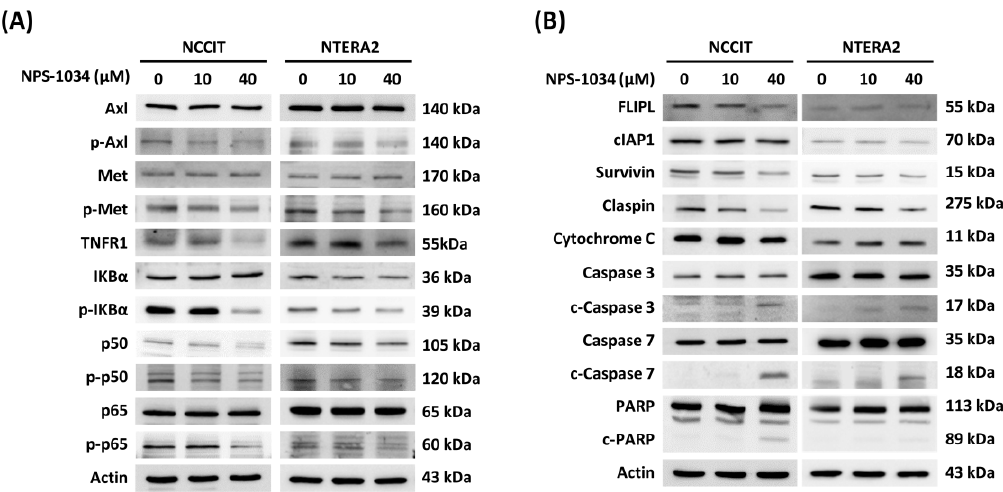
Figure 4. NPS-1034 potentially triggered an apoptotic pathway in TC cell lines via the TNFR1 pathway. ( A ) NPS-1034 inhibits the p-Axl, p-Met and downstream pathway NF- κ B of TNFR1, which might lead to certain gene expressions in both NCCIT and NTERA2 cell lines. ( B ) Proteins involved in the apoptotic pathways were determined following the treatment of NPS-1034 in TC cell lines.